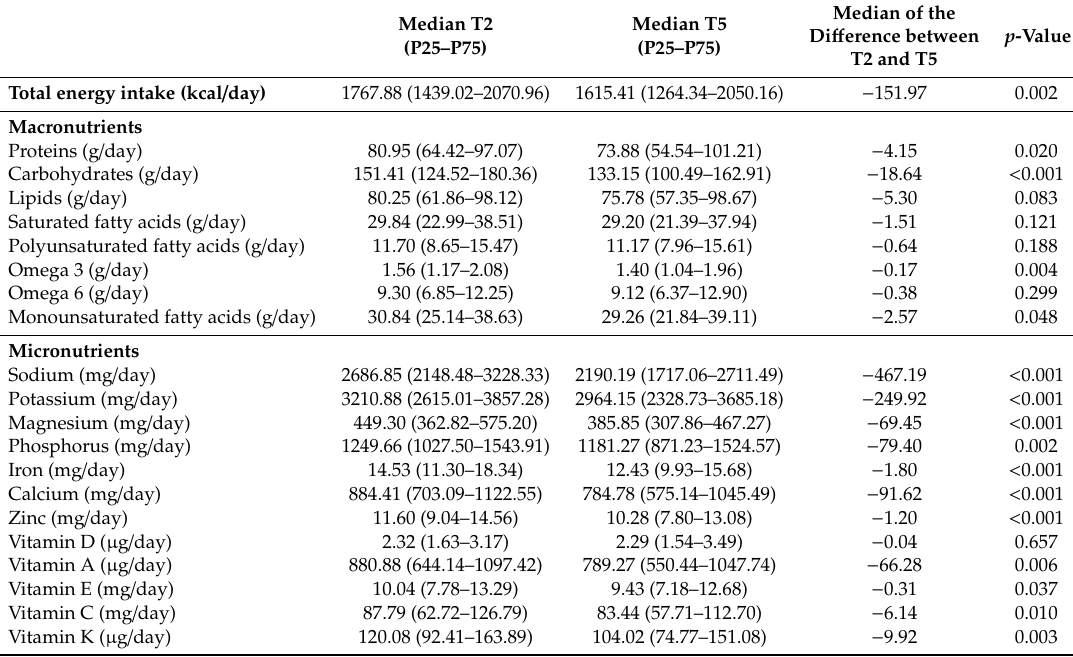
Table A1. Dietary consumption at T2 and T5 (absolute values of consumption).